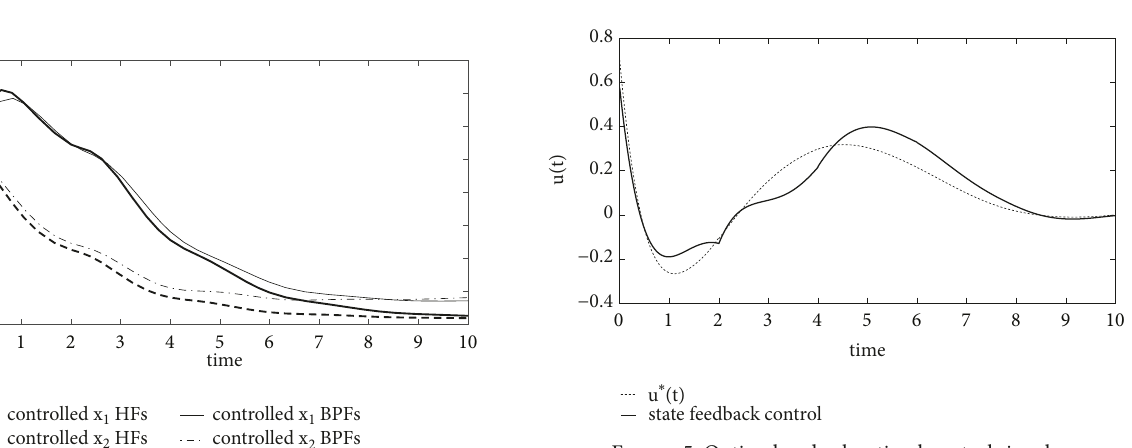
Figure 2: Optimal control signals with hybrid functions (HFs) and block pulse functions (BPFs).